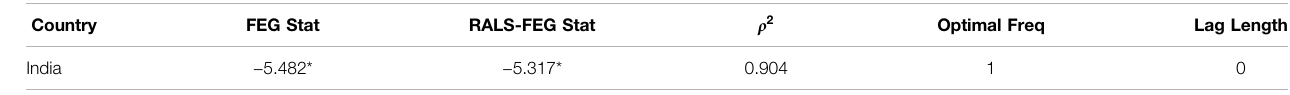
TABLE 3 | Results of cointegration tests. Country